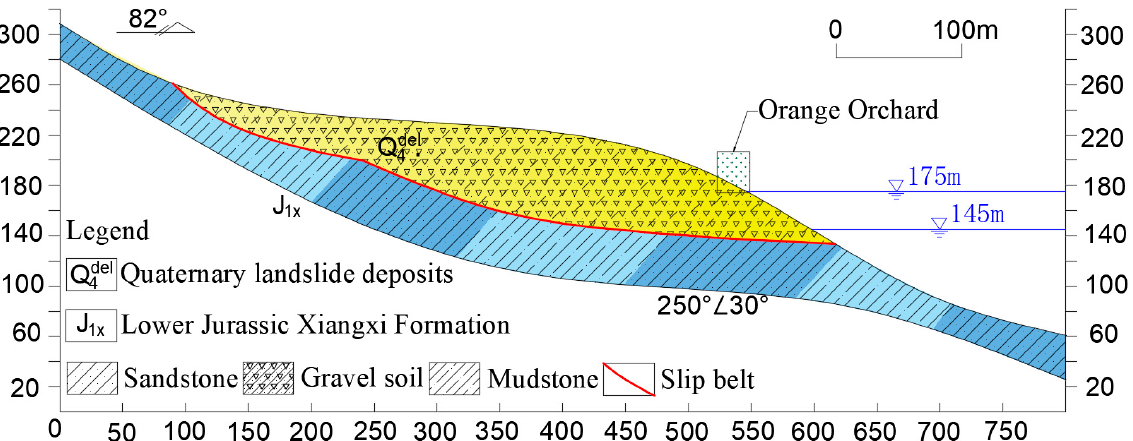
Figure 13. Longitudinal profile of the Baijiabao landslide.